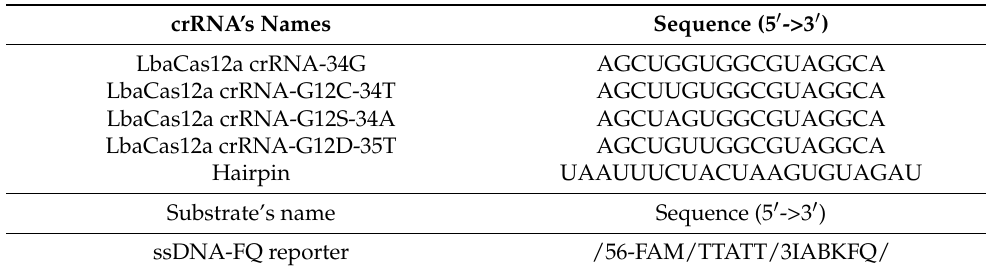
Table 1. Sequences of crRNA and reporter substrates.